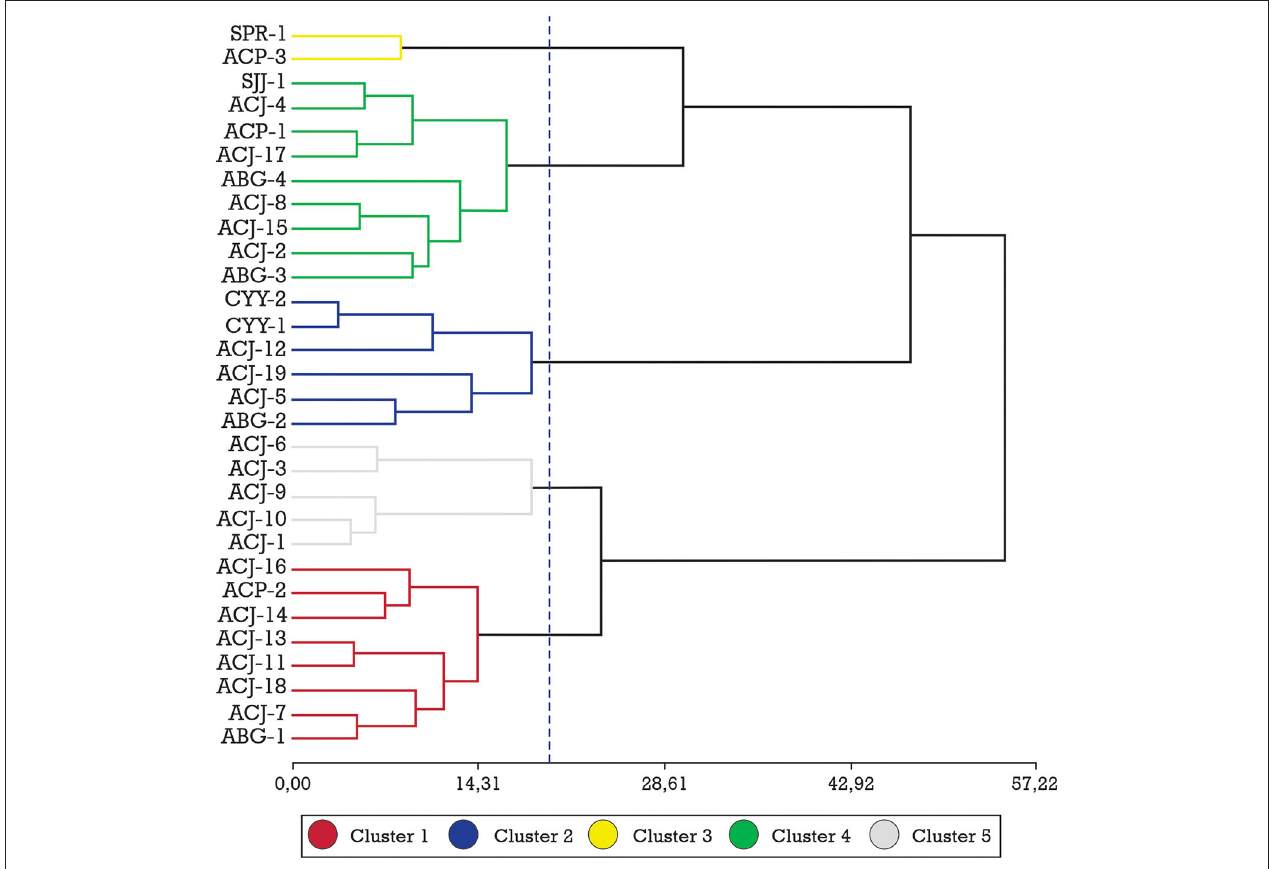
TABLE 3 | Means of the fatty acid profile variables for the 5 clusters of 30 ecotypes of native fine-aroma cocoa from the northeastern zone of Peru. Lipid profile Cluster 1